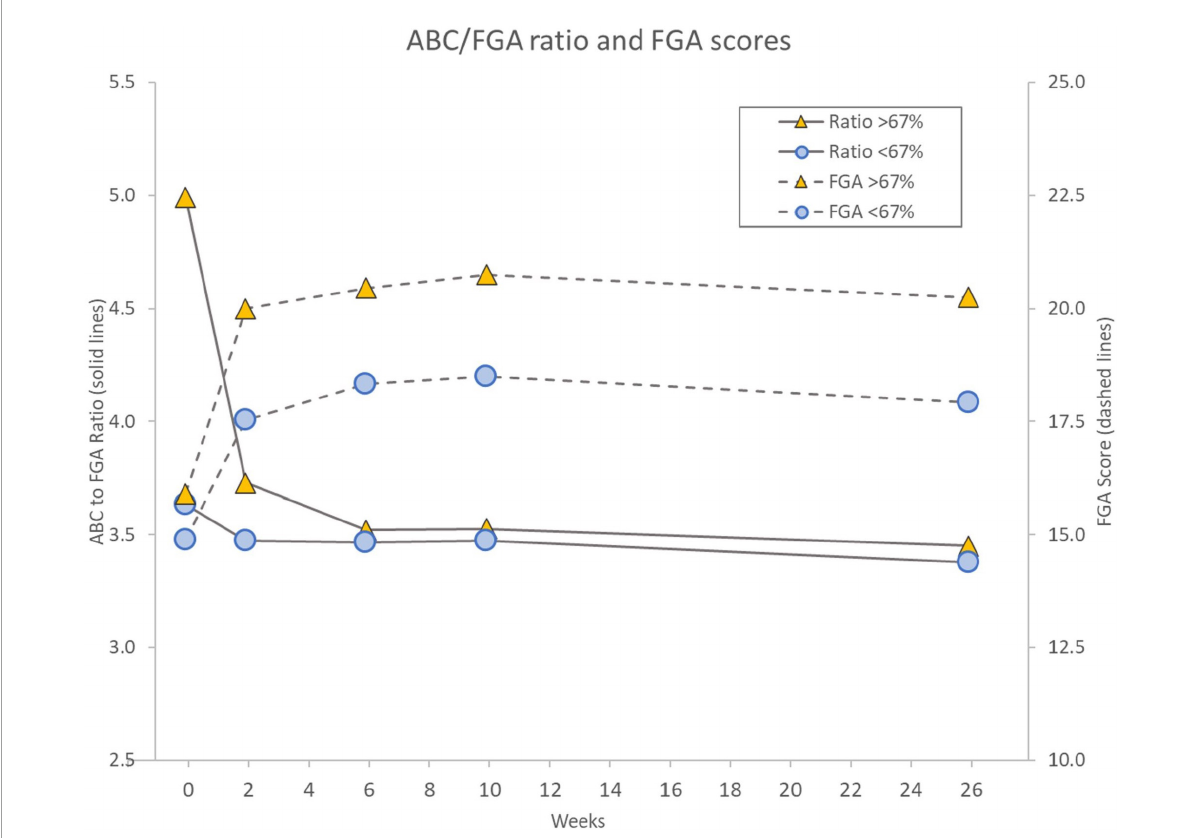
FIGURE5 Illustration of changes in ABC/FGA ratio (left axis, solid lines), an indication of self-perceived balance confidence in relation to externally observed gait function performance, for participants with baseline ABC scores > 67% (high balance-confidence, orange triangles) and those with ABC scores ≤ 67% (low balance-confidence, blue circles). The associated changes over time in FGA scores for the same two groups are also shown (right axis, dashed lines). Notice that both groups had similar FGA scores at baseline, which led to a dramatic difference in the ABC/FGA ratio at baseline. Over time, the ratio for the high balance-confidence participants gradually decreased and aligned with the low balance-confidence group at ∼ 3.5, mainly due to an increased FGA score and a maintained ABC score. The low balance-confidence group maintained an ABC/FGA ratio ∼ 3.5 throughout the 26 weeks associated with a proportional increase in ABC and FGA scores. Interestingly, the high balance-confidence group showed a higher increase in FGA score than the low balance-confidence